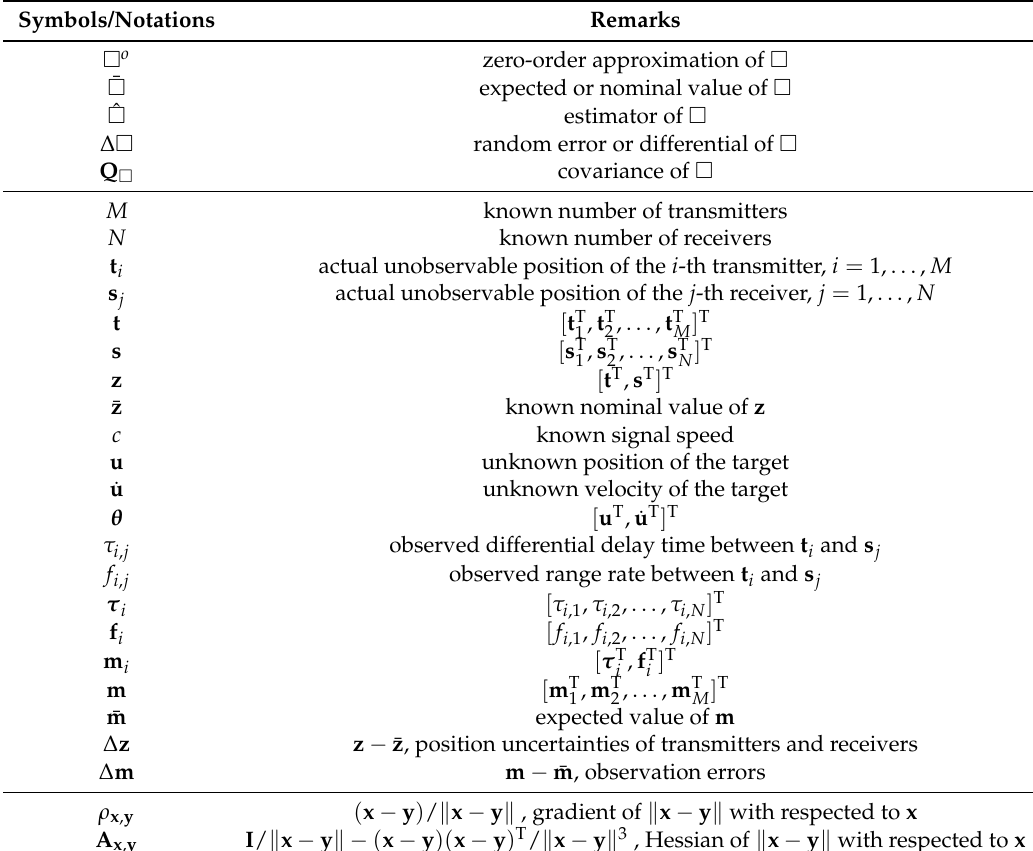
Table 1. List of symbols and notations ( (cid:3) as a placeholder